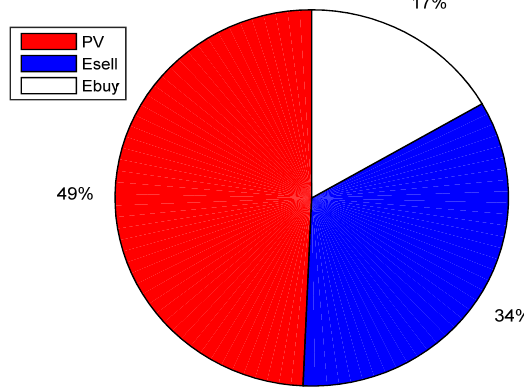
Figure 11. Annual energy share.